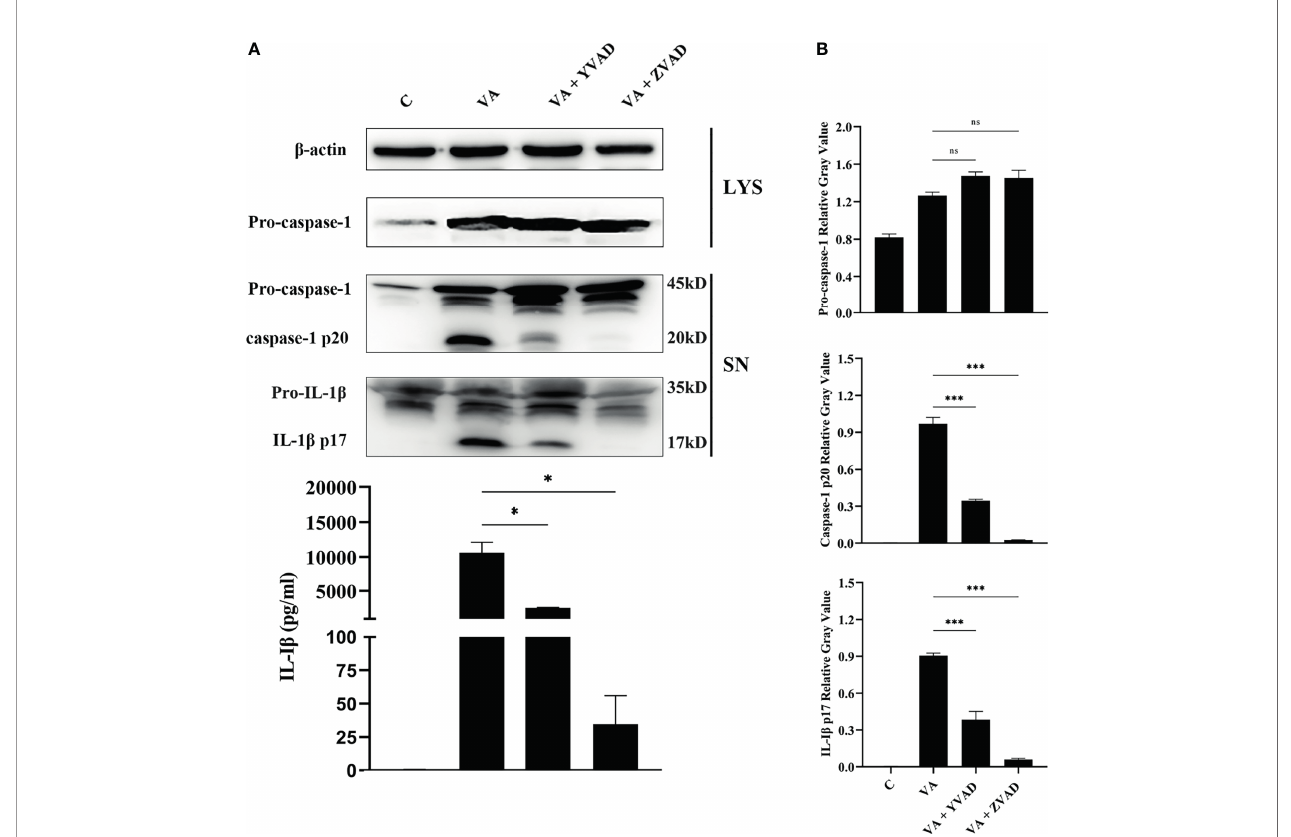
FIGURE 2 | IL-1 b release was dependent on the activation of caspase-1 after V. alginolyticus infection. (A, B) Macrophages were pretreated with 100 m M Ac- YVAD-CHO or 10 m M Z-VAD-FMK for 1 h and then infected with V. alginolyticus with MOI of 1 for 12 h; the protein expression levels of pro-caspase-1, caspase-1 p20, and IL-1 b p17 were detected by Western blotting, and the IL-1 b level band gray value with ImageJ, and the relative gray value was calculated through normalizing to b -actin. Data from ELISA and Western blotting results were representative of at least three independent experiments. * p < 0.05, *** p < 0.001, ns, not signi fi